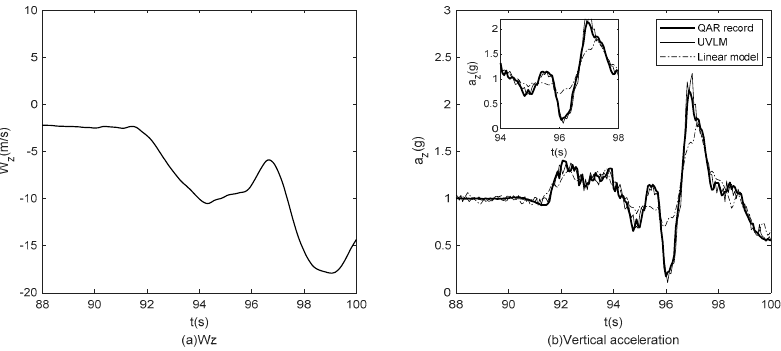
Figure 8. Vertical wind and acceleration response in WF6. ( a ) W z ; ( b ) vertical acceleration.